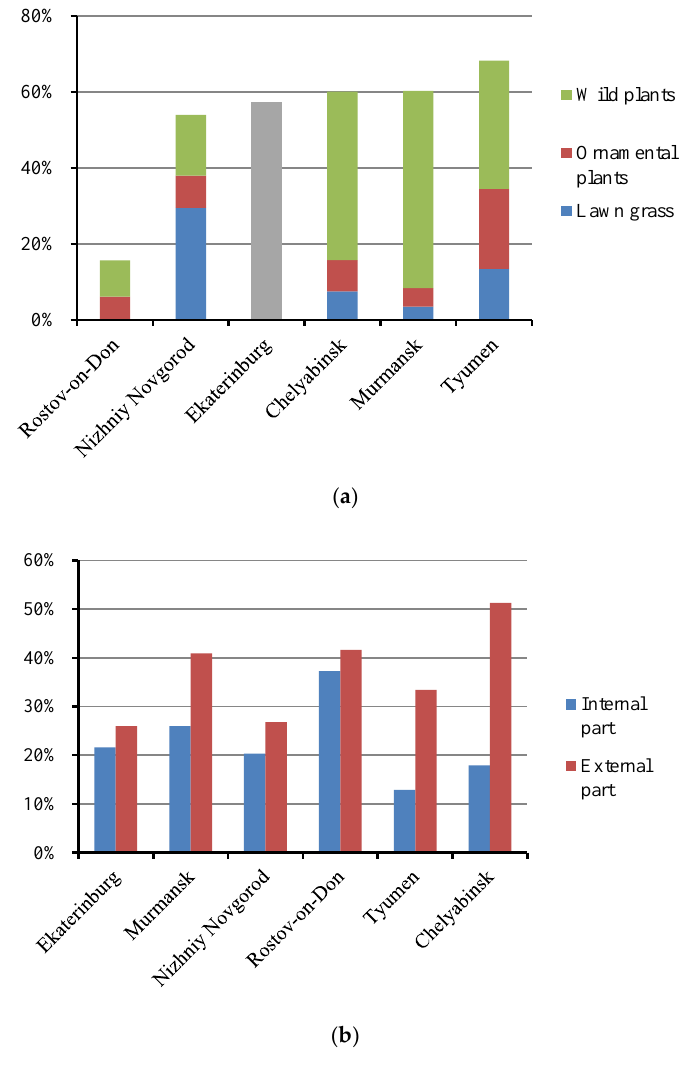
Figure 7. ( a ) Projective grass cover in lawns, taking into account the contributions of wild plants, lawn grass, and ornamental plants. In Ekaterinburg, the study was conducted according to another scheme. ( b ) Projective tree canopy cover of external and internal parts of the EURL.